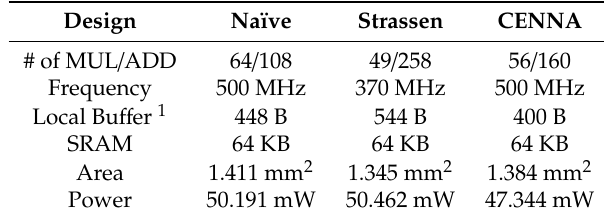
Table 4. Summary of implementation evaluations of three neural network accelerators.